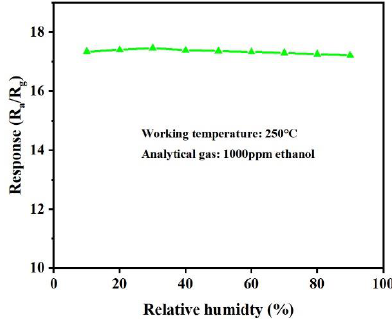
Figure 10. Sensing response at different RH levels for ethanol concentrations of 1000 ppm at 250 ℃ .